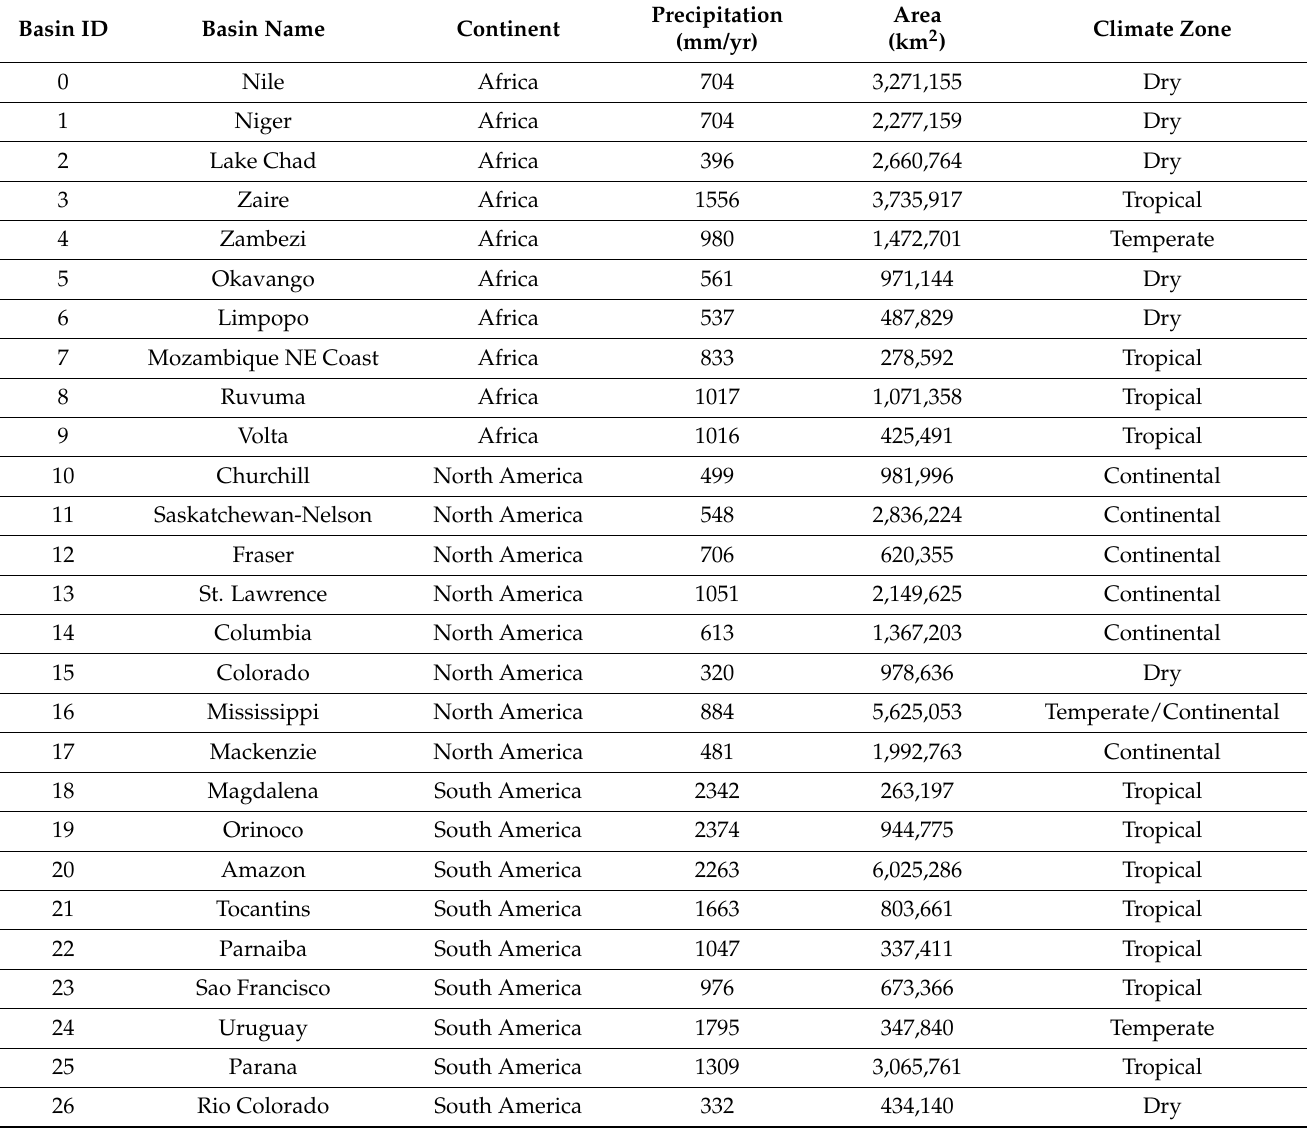
Table A1. Characteristics of global 62 major river basins used in this